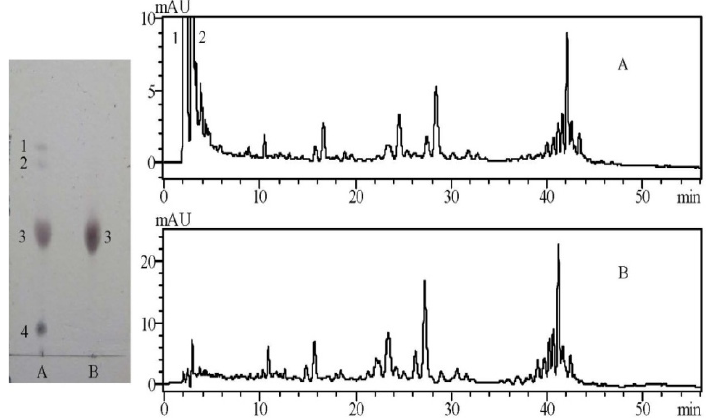
Figure 1. TLC and HPLC/UV analysis of saponins (( A ) Crude saponins and ( B ) Purified saponins).